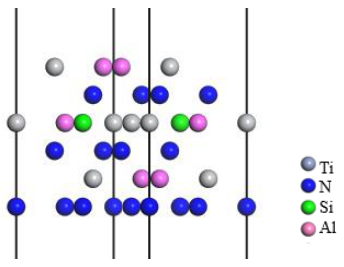
Figure 2. TiAlSiN interface model with vacuum layer.